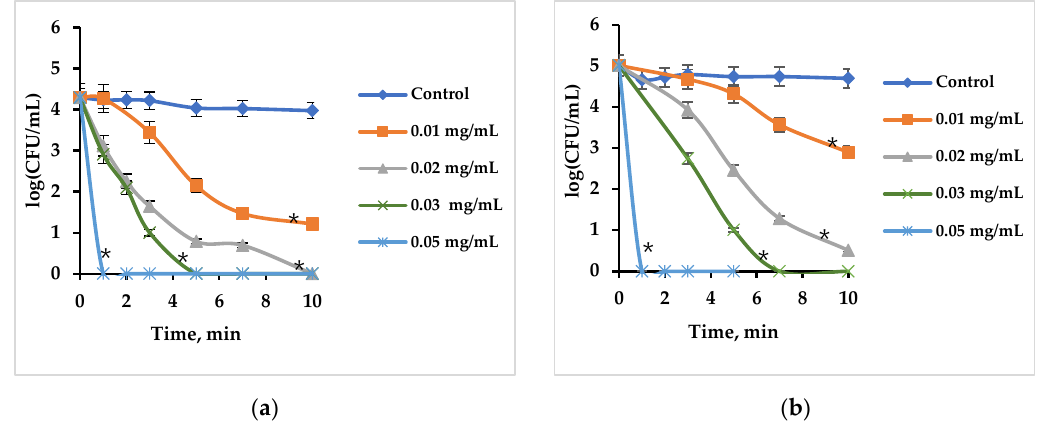
Figure 2. Effect of free Rose Bengal at various concentrations in the dark under ultrasonic excitation on S. aureus at initial concentrations of ( a ) 10 4 and ( b ) 10 5 CFU/mL. Control — S. aureus cells treated by ultrasound only. Error bars present standard deviations. The asterisk ( * ) denotes statistically significant differences with the control ( p < 0.05).